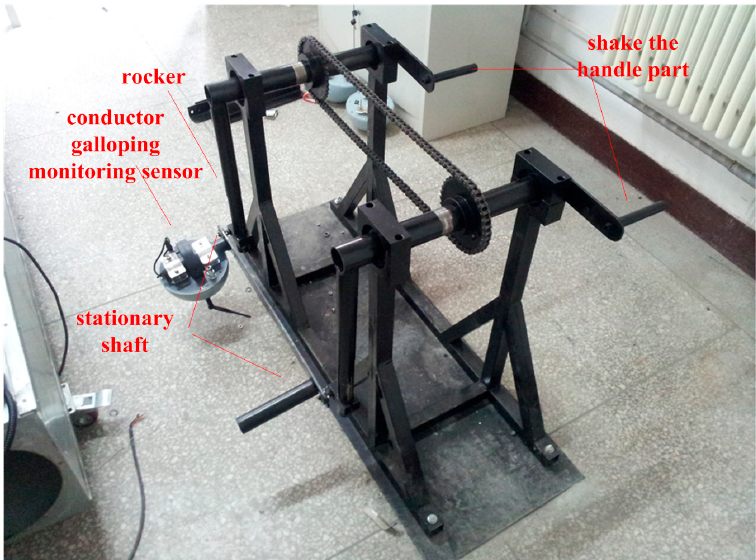
Figure 14. Accuracy test setup.